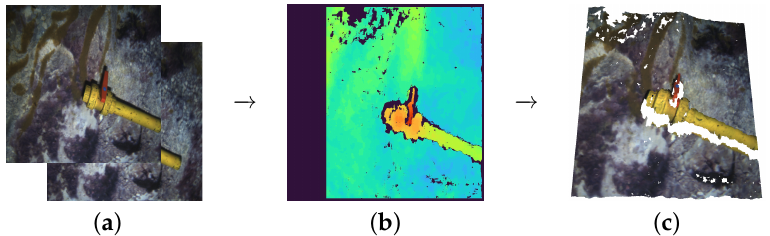
Figure 2. Data acquisition process: ( a ) Left and right stereo images from a calibrated stereo rig; ( b ) Disparity depth image obtained using ROS stereo processing [51]; ( c ) Point cloud generated by merging depth and colour information (Blank spaces correspond to areas where no matching between stereo images could be found or to covered areas).